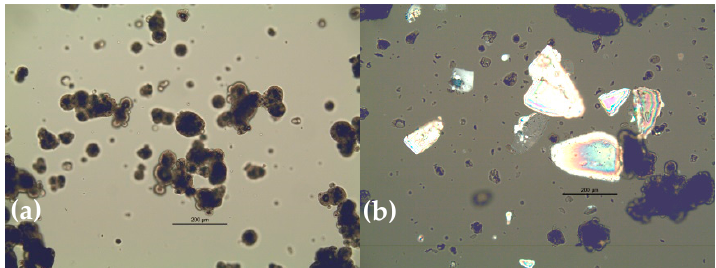
Figure 1. Polarised light images of ( a ) Type I (powder 1) and ( b ) II (powder 10) powders. Scale bar is 200 μ m.